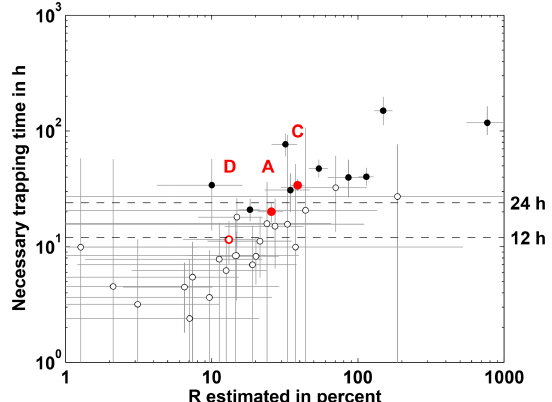
Figure 10. Necessary trapping time to explain observed differences between N 2 O concentrations at 5 and 10m, as a function of R . De- pletion of the top 5m layer by air–sea gas exchange due to observed wind is assumed. Due to the sparse resolution of N 2 O profiles at ship stations, R is estimated by setting c bulk = c 5m and c ns = c 10m